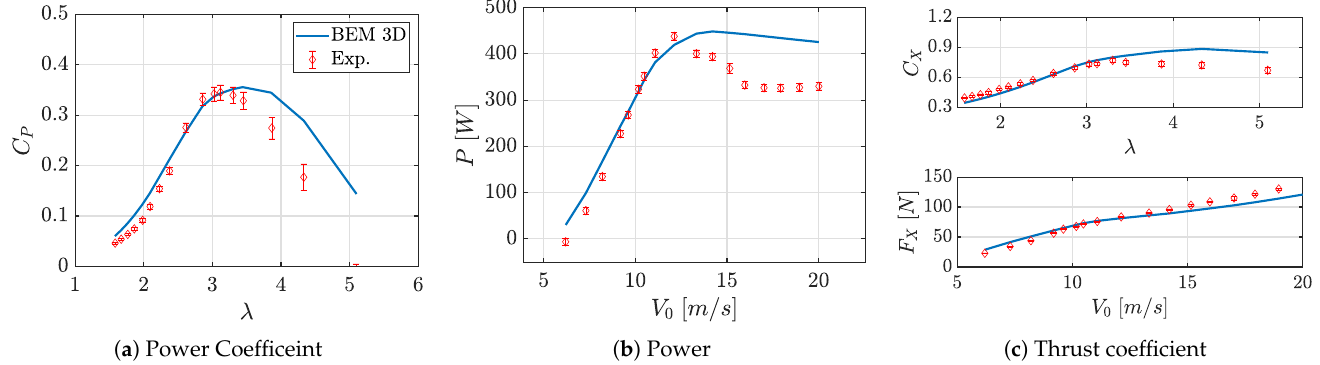
Figure 6. Comparison of experimental and 3D BEM results for the Troposkein-shaped 450 W